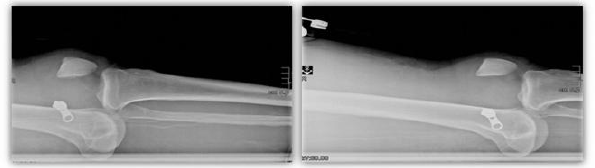
Figure 1: X-ray revealing anterior dislocation of the knee with fracture of the left fibula head.